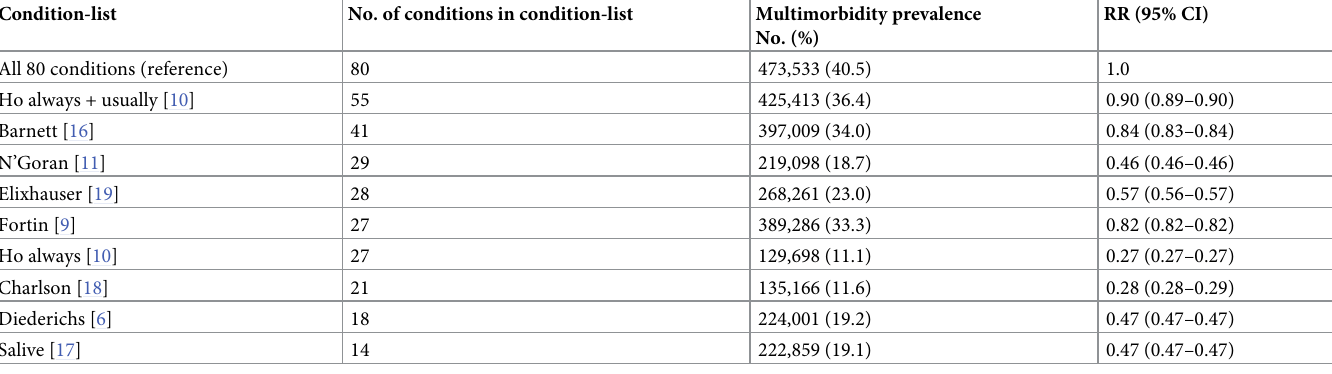
Table 3. Multimorbidity prevalence using existing condition-lists and RR of multimorbidity when considering all 80 conditions (ceiling effect where adding addi- tional conditions had little impact on